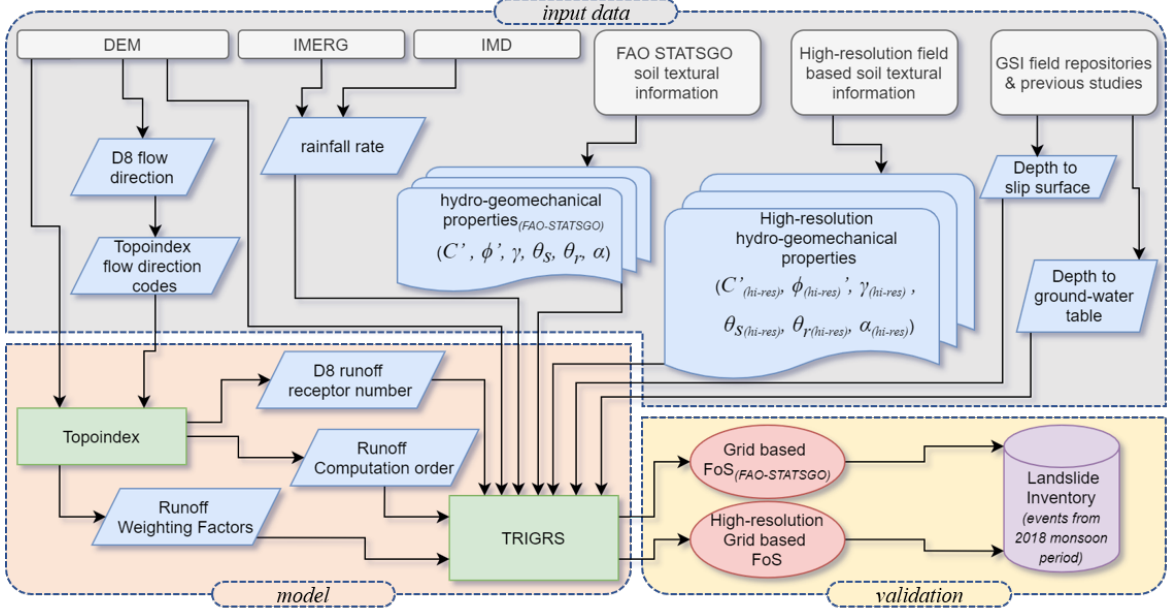
Figure 9. Schematic diagram of the methodology adopted in the present study. The derivation of the input data sets, application of the model, and validation of the output (grid-based FoS) from hydrogeomechanical properties through FAO-STATSGO and high-resolution hydrogeomechanical properties through field-based DSSSC against the landslide inventory are graphically represented in the diagram.